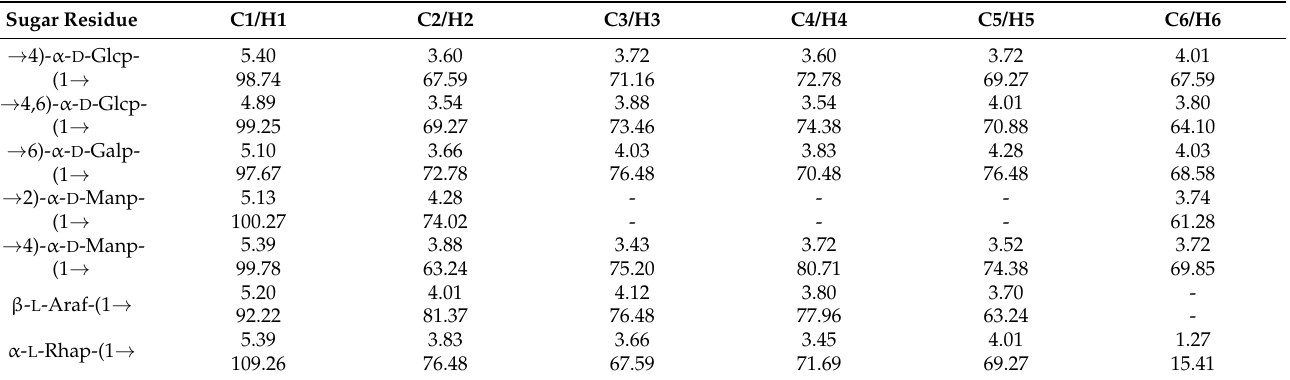
Table 2. 13 C and 1 H NMR chemical shifts (ppm, δ ) for DLP-3.